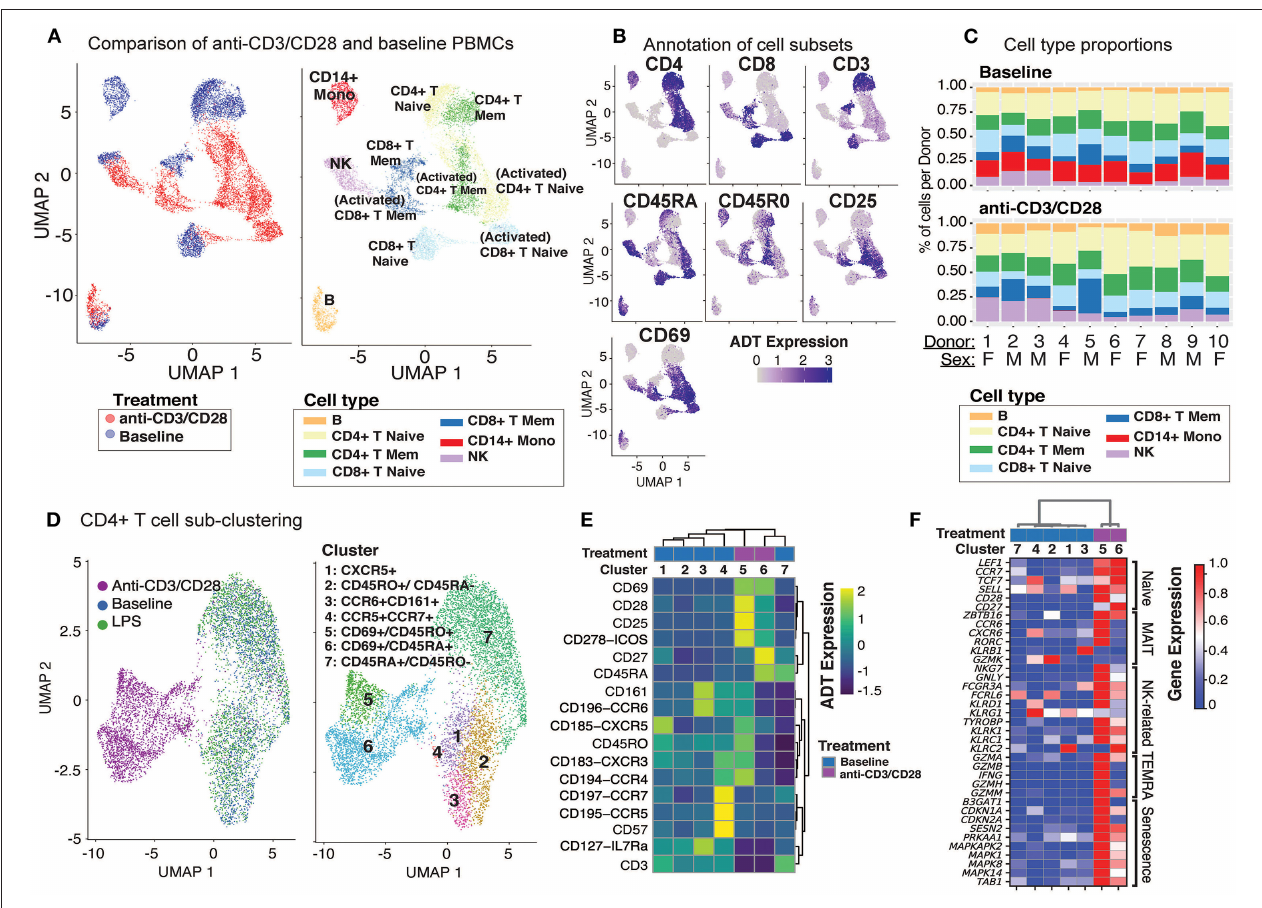
FIGURE 2 | Anti-CD3/CD28 stimulation activates all classes of lymphocytes. (A) Clustering of PBMCs at baseline and anti-CD3/CD28 conditions separates lymphocytes (NK, T, and B cells) primarily by cell type and secondarily by condition. Cells are color-coded based on activation condition (left) and cell types inferred via CITE-seq antibodies (right). (B) Annotation of cells at baseline was performed using protein expression levels of CD3, CD4, CD8, CD45RA, CD45RO, and additional annotation of activated T cells was done using expression of CD25 and CD69. (C) Cell type proportions across 10 donors at baseline (top) and anti CD3/CD28 condition (bottom). Note the decline in CD14 + monocytes (red bars) upon anti-CD3/CD28 condition. (D) Unsupervised clustering of all CD4 + T cells separates anti-CD3/CD28-stimulated cells from those at baseline and LPS activation. Dimension reduction plot with CD4 + T cells colored by their resultant cell type identity. (E) Average scaled expression of protein markers used to identify and annotate CD4 + T cell subsets. (F) Average scaled expression of marker genes associated with naive, MAIT, NK, TEMRA, and senescence